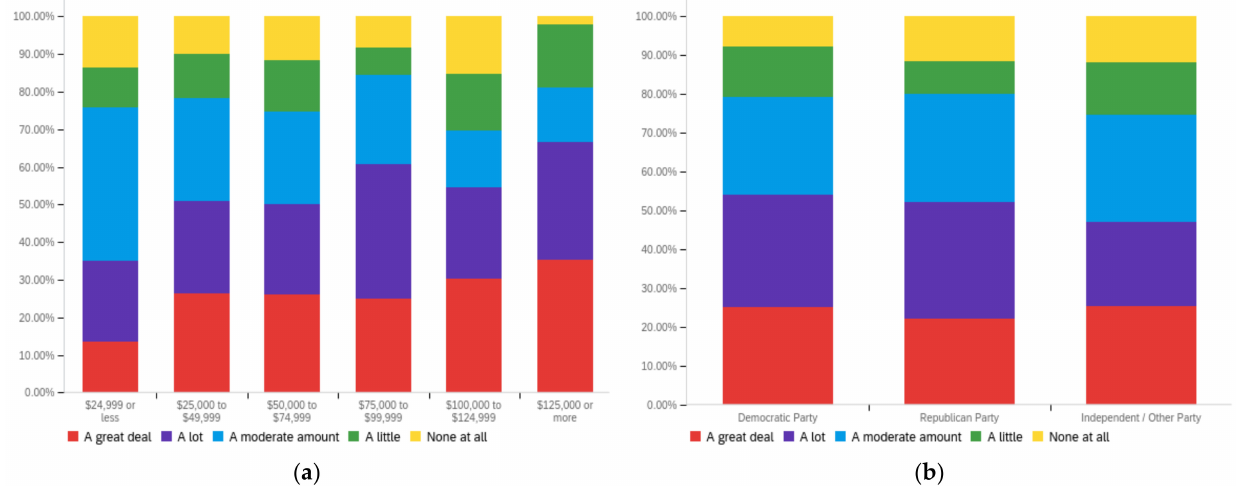
Figure A16. Cont